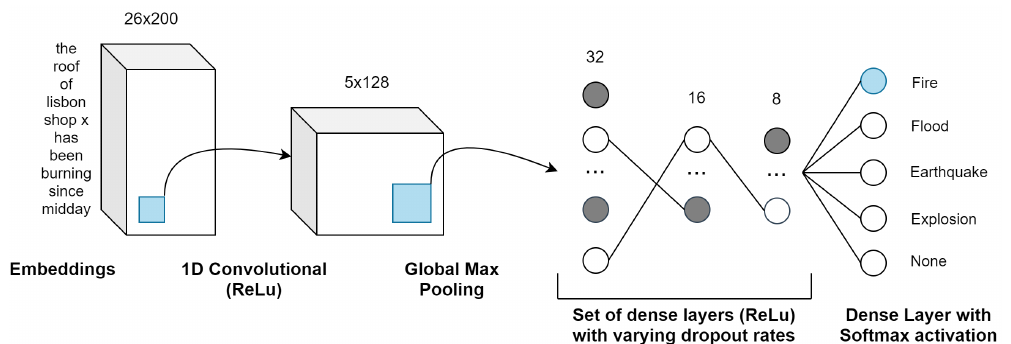
Figure 3. Threat type classification convolutional neural network